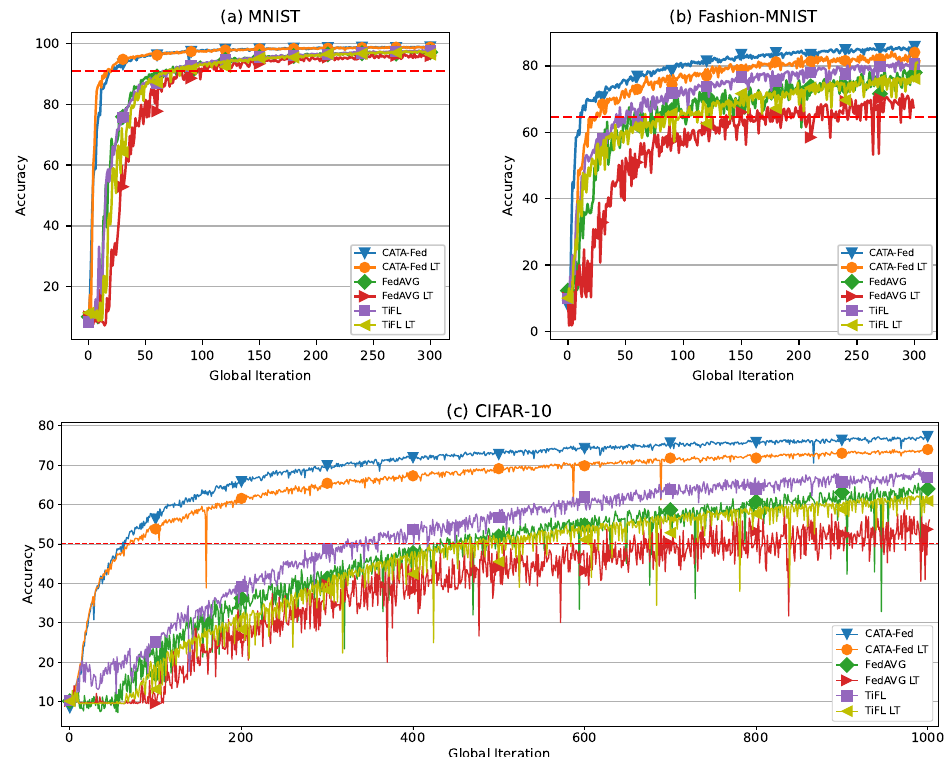
Figure 15. Test set accuracy vs. global iterations for ( a ) MNIST, ( b ) Fashion-MNIST, and ( c ) CIFAR-10 under the condition of long-tail distribution with the number of cluster P = 8, deadline T = 1, and class bias H = 1. Table 5. Comparison of average test accuracy according under the long-tail distribution. Class